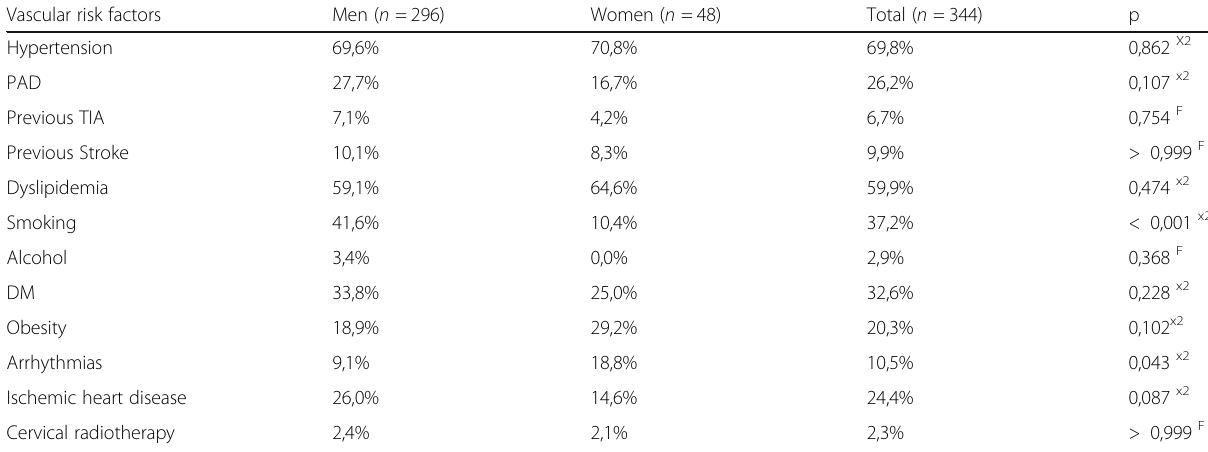
Table 1 Baseline characteristics of patients Vascular risk factors